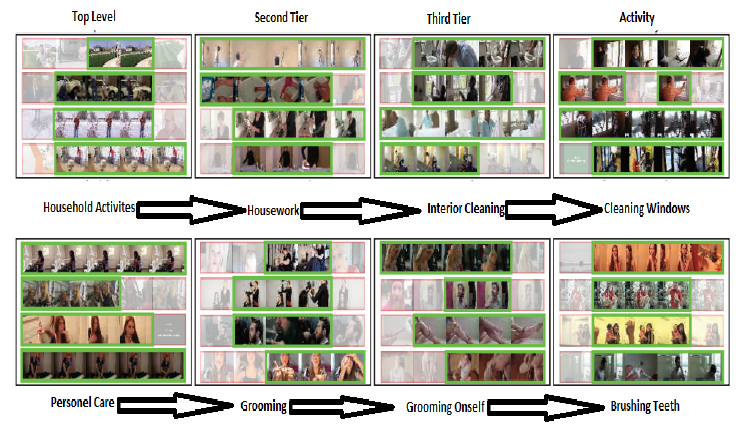
Figure 19. Exemplar frames from ActivityNet dataset